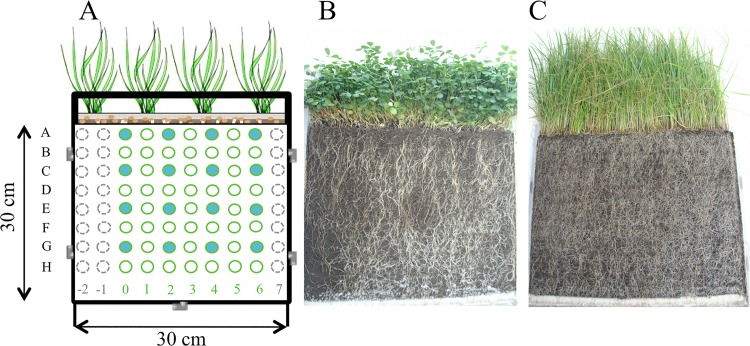
Illustration of the rhizotron device.(A) Sampling map showing the 56 samples (in green). The 8 depths are labeled from A to H and the 7 replicates are labeled from 0 to 6. Twenty-four supplemental samples (in gray) were used for soil humidity measurements. On sixteen samples per device (in blue) further analyses of pH, bioavailable PAHs, carbohydrates and dissolved organic carbon (DOC) were performed. Pictures of alfalfa (B) and ryegrass (C) rhizotron devices after 37 days.